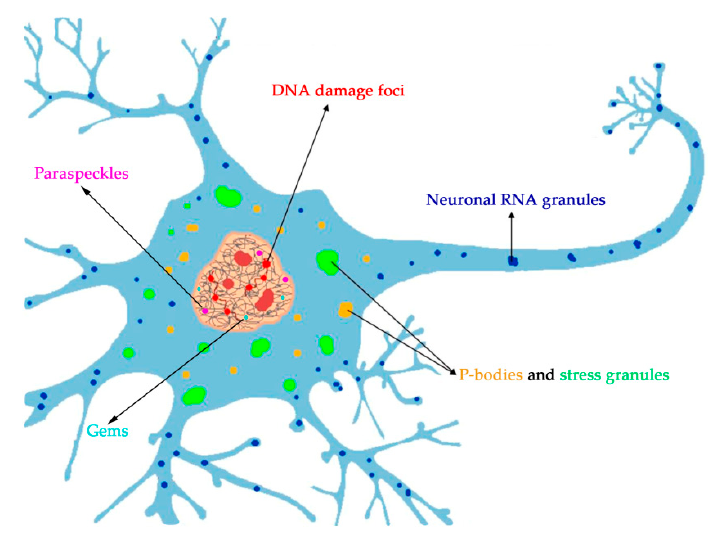
Figure 2. Schematic illustration of a neuronal cell and membrane-less compartments generated with the participation of FUS in the nucleus and cytoplasm. We corrected the Figure 2 (Please, see the attached file).